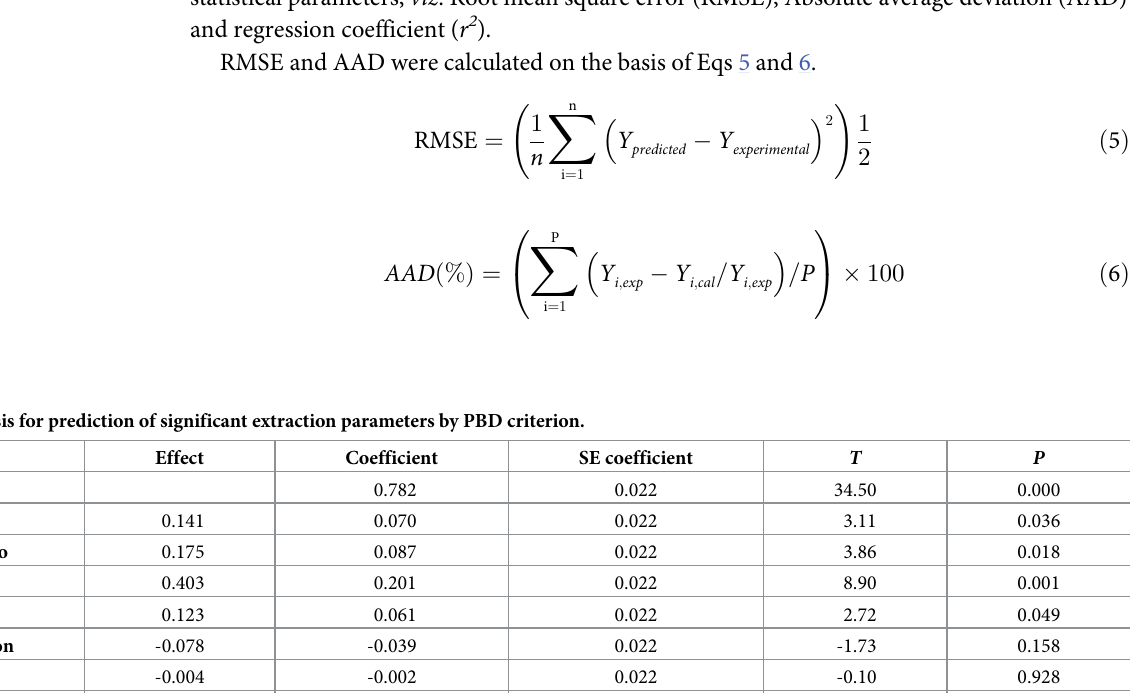
accurate without any compromises. The multilayer perceptron model consists of four inputs, one hidden and output layer for prediction. For training and validation analysis, Log Sigmoi- dal function is used as an activation unit for non-linear output prediction. For synaptic weight adjustment and analysis training data is trained with help of Marquardt algorithm and valida- tion is supported and performed with the help of 5-fold cross validation strategy. Fig 6A depicted the performance data obtained over entire training data and fitted at best epochs for validation data being represented. Similarly, gradient loss and training state achieved over entire ANN training is explained with help of Fig 6. In addition, comparison was drawn between two models on the basis of three significant statistical parameters, viz . Root mean square error (RMSE), Absolute average deviation (AAD) and regression coefficient ( r 2 ).